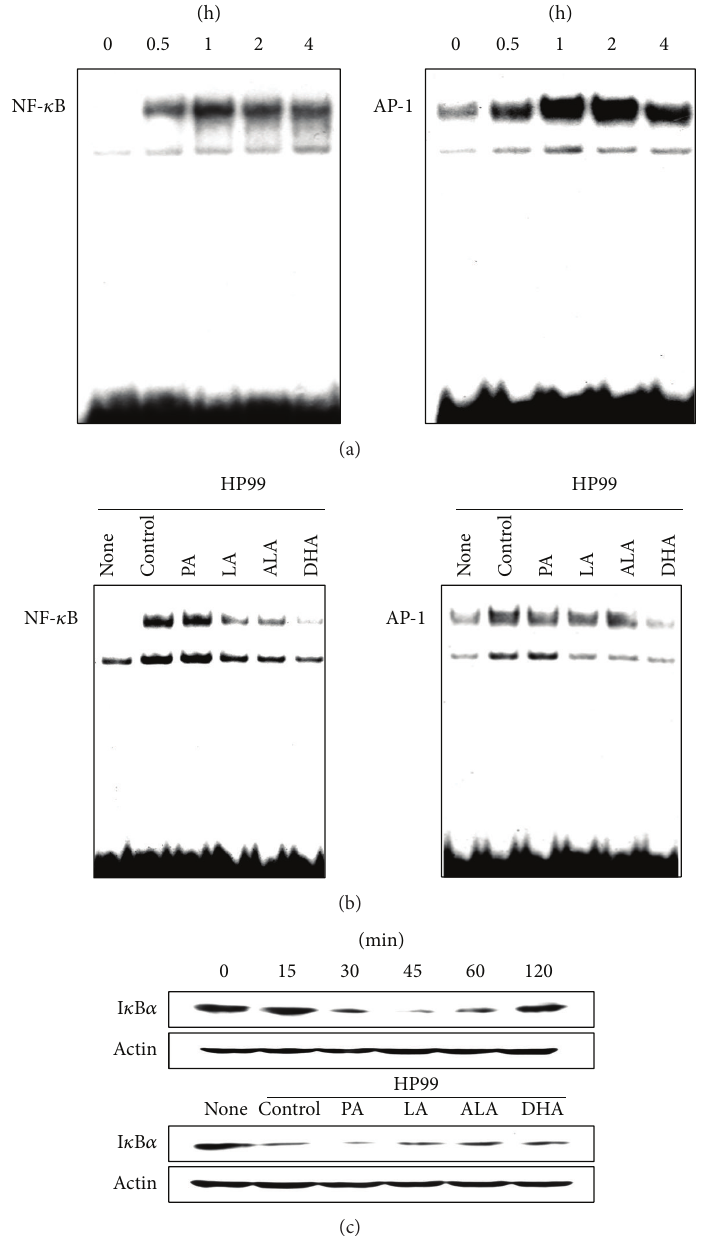
Figure 3: Effects of PUFAs on H. pylori -induced activation of NF- 𝜅 B and AP-1. (a) AGS cells were infected with H. pylori for indicated time periods (0.5, 1, 2, and 4 h). Nuclear extracts were harvested and the DNA-binding activities of NF- 𝜅 B- and AP-1 were determined by electrophoretic mobility shift assay. (b) AGS cells were pretreated with individual fatty acid (100 𝜇 M) for 24 h and stimulated with H. pylori for 1h. (c) H. pylori -induced degradation of I 𝜅 B 𝛼 was analyzed by western blotting at the indicated time points (15, 30, 45, 60, and 120 min; upper panel). AGS cells were pretreated with individual fatty acid (100 𝜇 M) for 24 h and infected with H. pylori for 30 min (lower panel). Actin was used as a loading